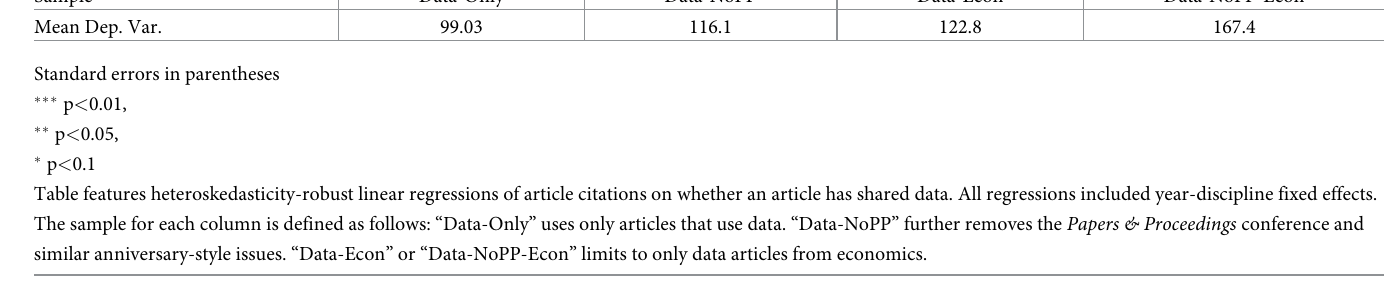
Table features heteroskedasticity-robust linear regressions of article citations on whether an article has shared data. All regressions included year-discipline fixed effects. The sample for each column is defined as follows: “Data-Only” uses only articles that use data. “Data-NoPP” further removes the Papers & Proceedings conference